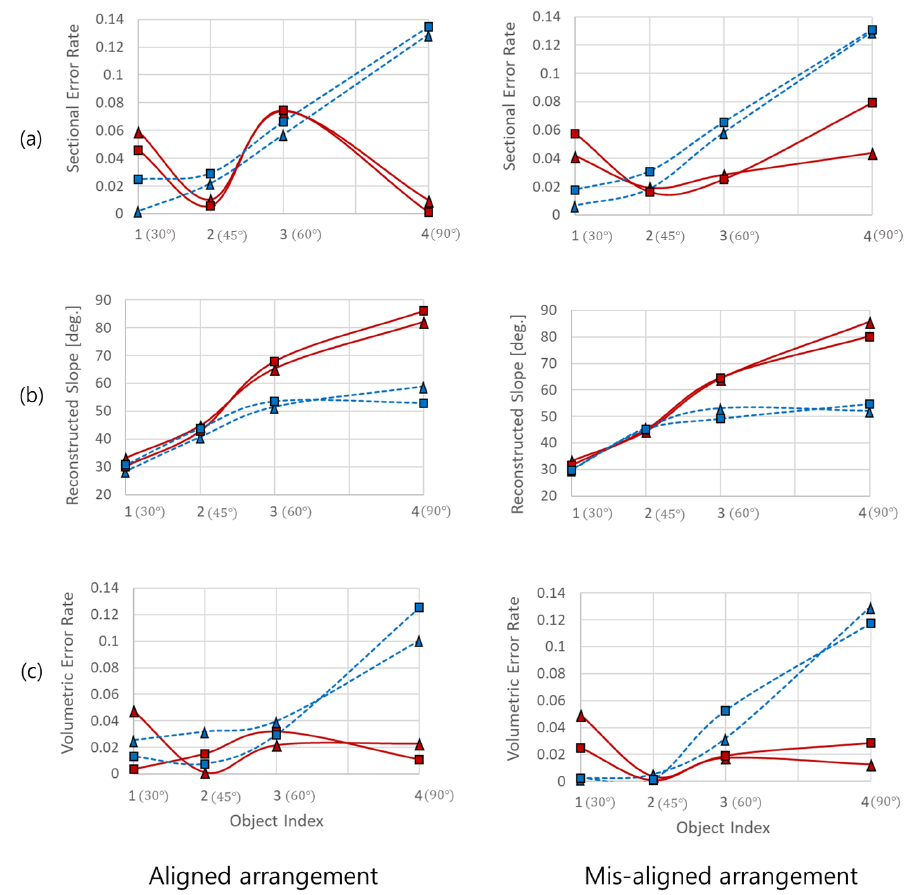
Figure 9. Comparison results: ( a ) sectional error rate, ( b ) reconstructed slope, and ( c ) volumetric error rate. Red and blue lines represent the proposed and single-sonar methods, respectively; solid and dashed lines represent the aligned and misaligned deployments, respectively; square and triangle symbols represent the first and second objects,